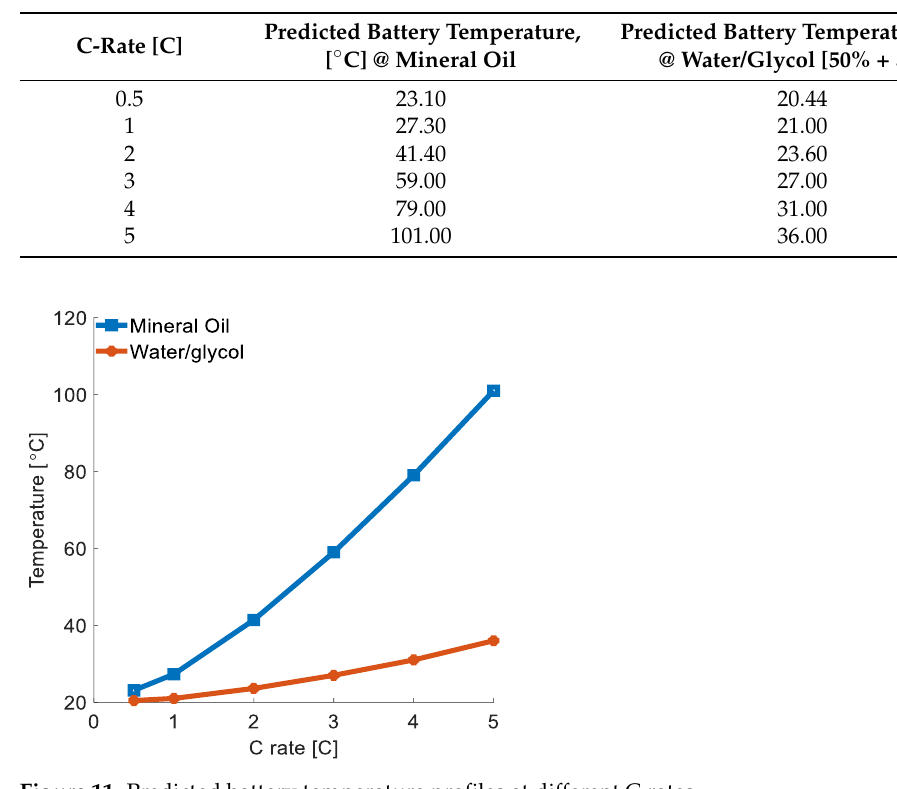
Table 6. Predicted battery temperature with various coolants.